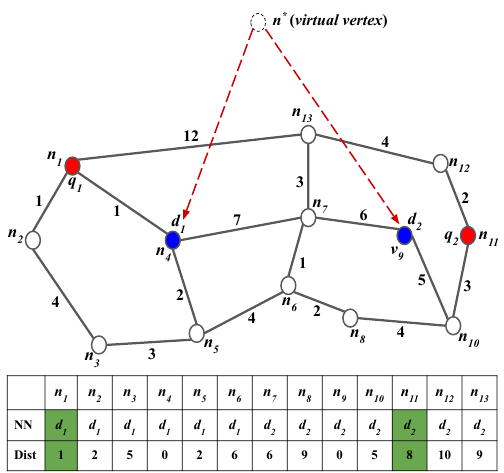
Figure 12. An example of VIVET at t 1 , the green box indicates the query results.